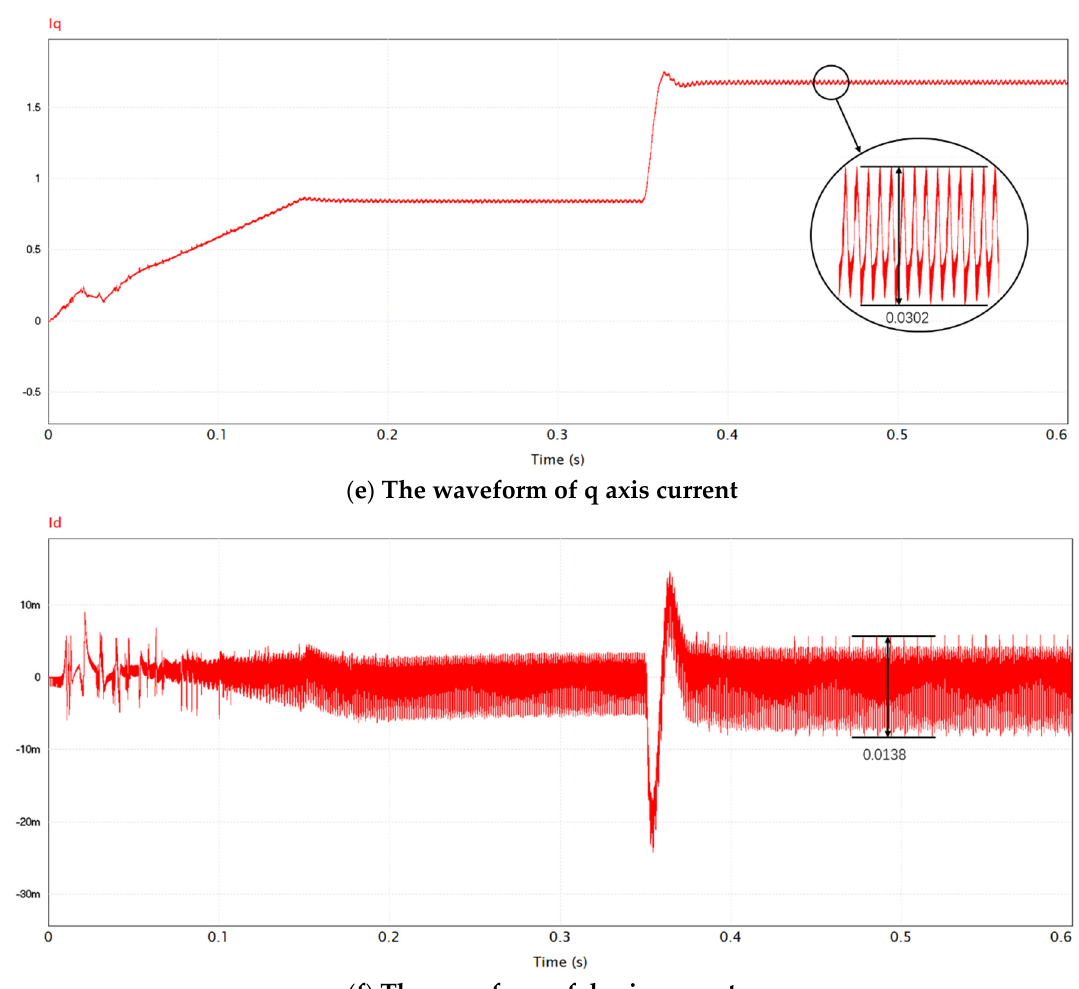
Figure 10. Simulation result of conventional SMC.